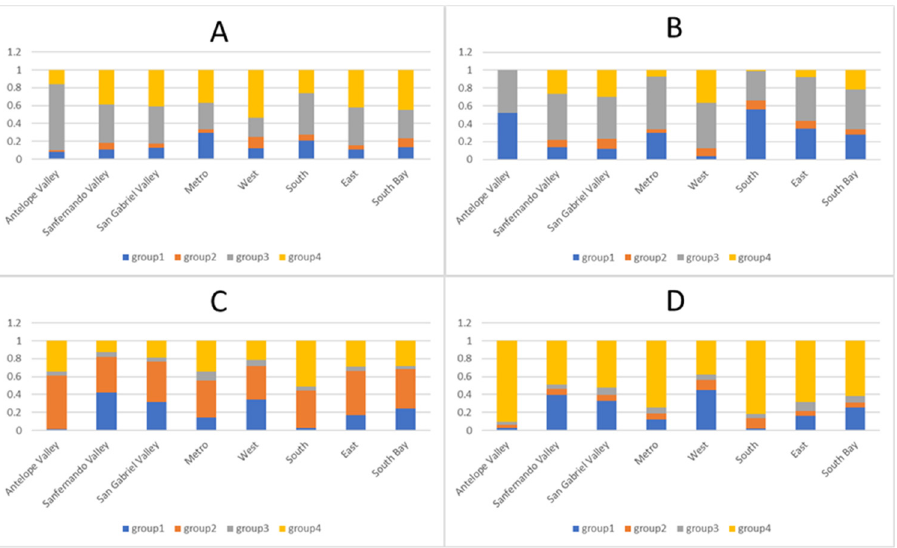
Figure 3. Percentages of tracked devices of different HMP groups in SPAs of LA county (subfigures explained in Section 3.2).